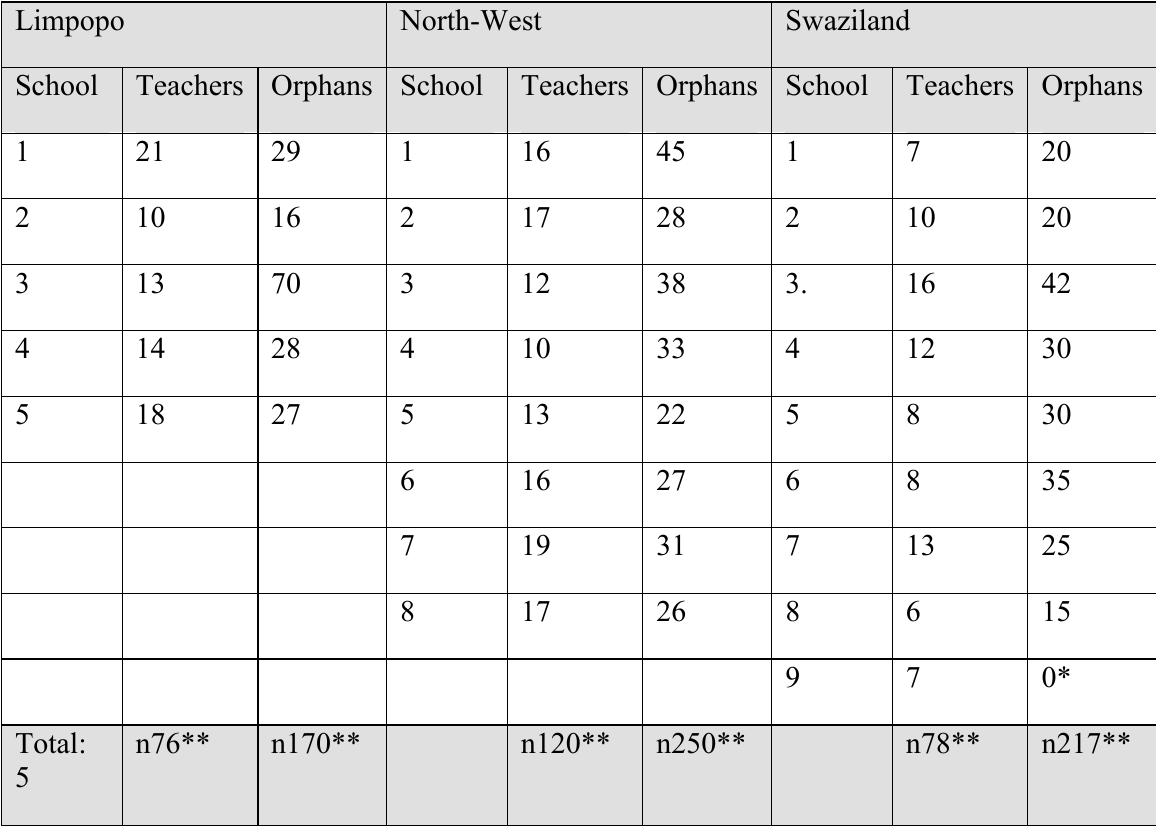
Tables: Orphans in developing countries: What do their responses indicate? Table 1. Number of schools, teachers and orphans involved